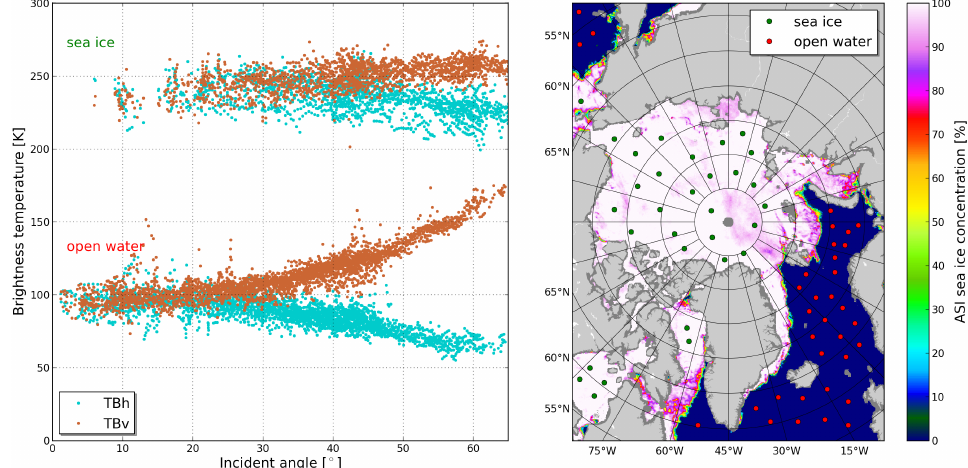
Fig. 1. Testing large area of brightness temperatures throughout the whole Arctic area from 20 April 2012. Right: ice concentration from SSM/I and test areas for sea ice (green bullets) and open water (red bullets). Left: the corresponding brightness temperature dependence on the incident angle.